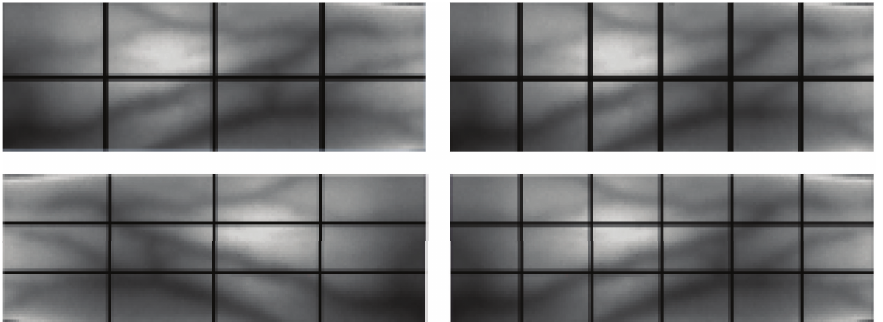
Figure 2: Different types of finger vein image partitioning structures.